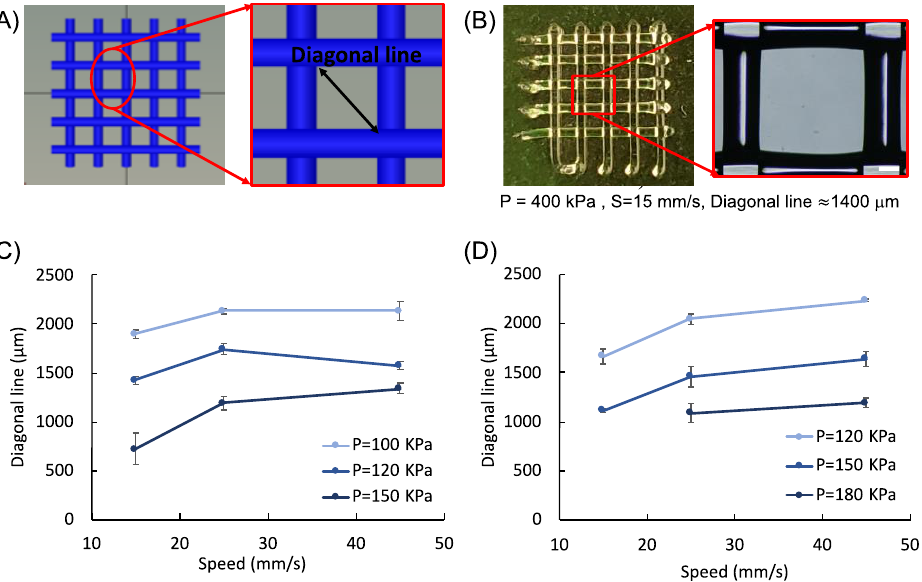
Figure 8. Characterization of printability. ( A ) Images showing the grid design and measurement of the diagonal line. ( B ) Results from pluronic inks. Scale bar is 200 microns. ( C , D ) Diagonal line length with respect to print pressure and speed for neat ( N ) and composite ( C ) scaffolds.